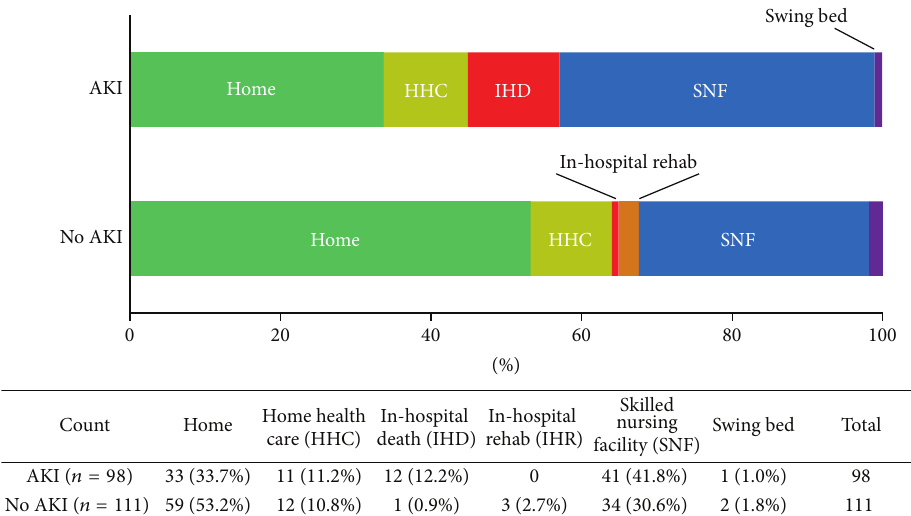
Figure 1: Patient disposition.